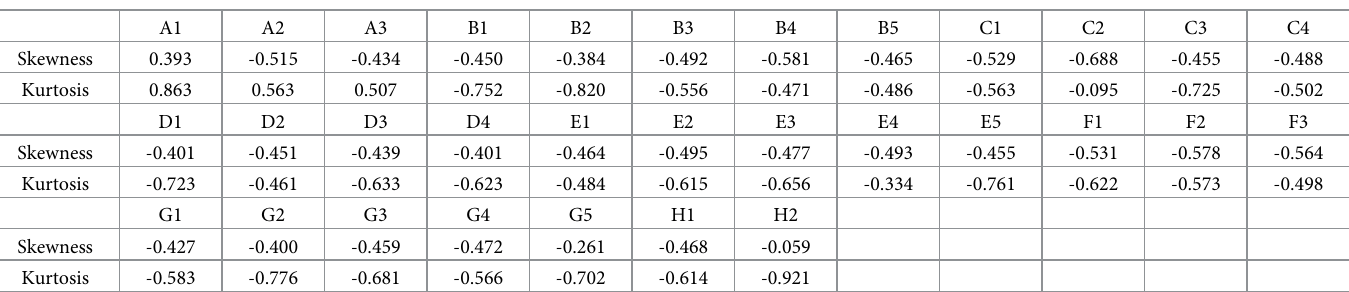
Table 3. The values of skewness and kurtosis.